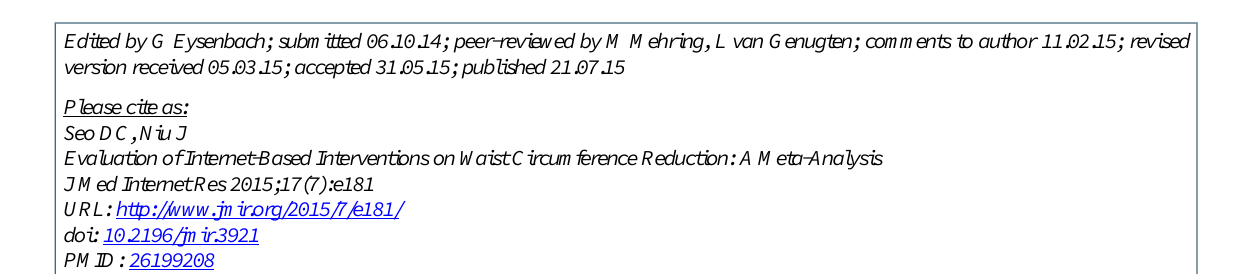
BIT: Behavioral Intervention Technology ERIC: Educational Resource Information Center RCT: randomized controlled trial